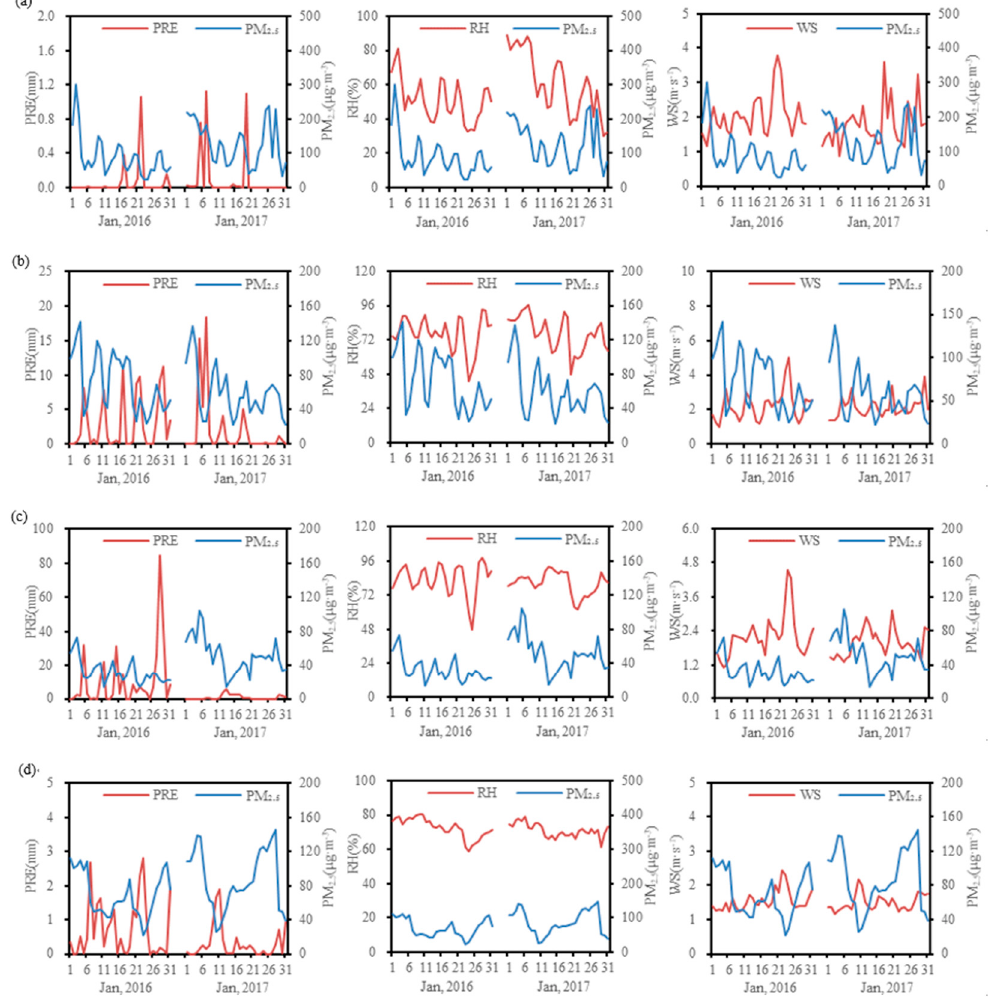
Figure 5. Comparison of daily meteorological parameters and PM 2.5 concentration in ( a ) JJJ, ( b ) YRD, ( c ) PRD, ( d ) CYB.